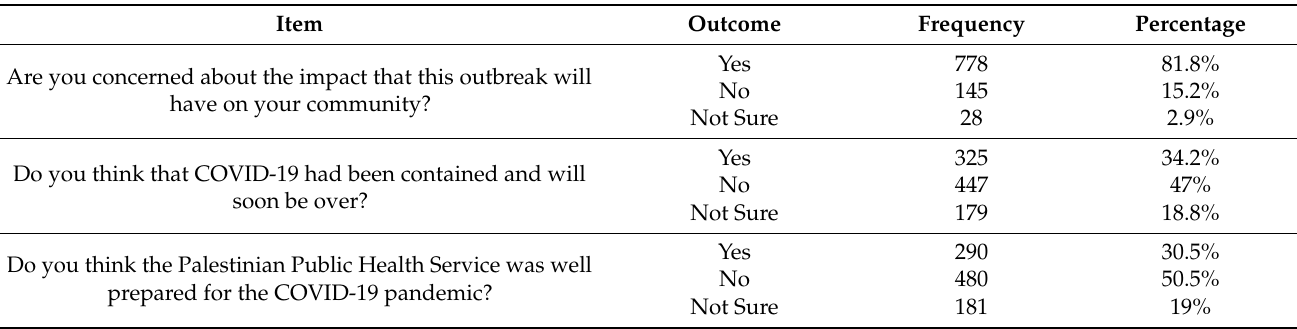
Table 4. Responses of the participating Palestinian students to the COVID-19-related attitudes subscale, May 2020 ( n = 951).